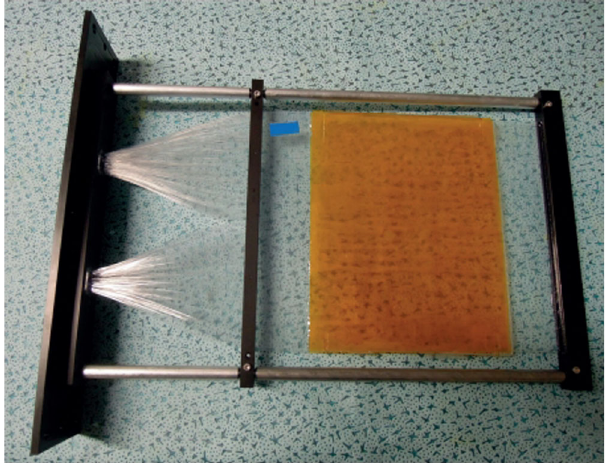
FIG. 13. Particle identification with the combined use of Cherenkovs and time of flight techniques. At 1 GeV =c , and when the low pressure Cherenkov does not give signal, pions/ muons can be identified with a peak around 95 ns and protons around 130